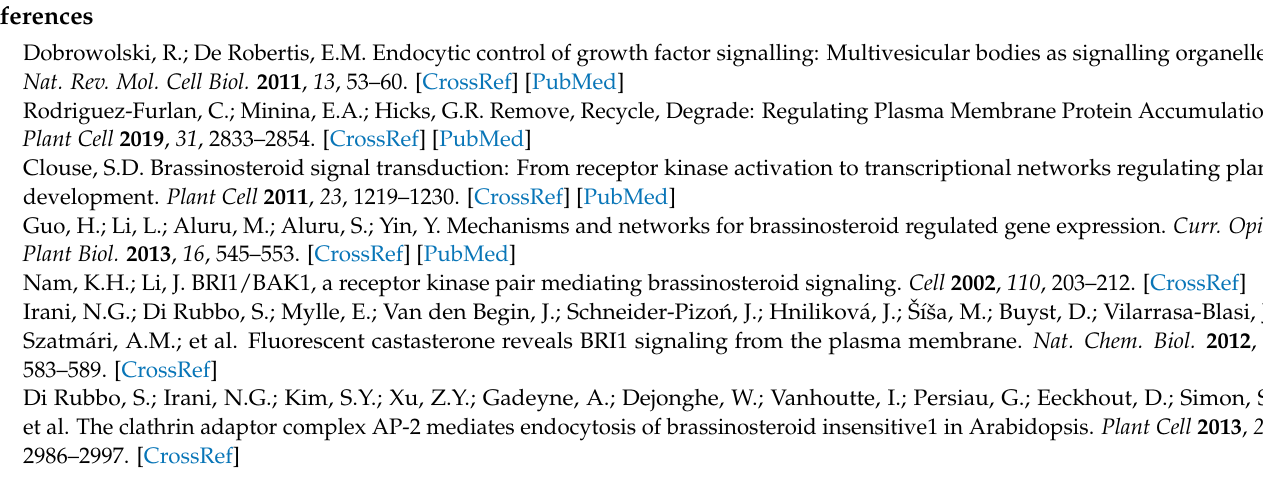
Figure S2: HSP90.1 and HSP90.2 reside at the PM; Figure S3: BRI1LRR and BRI1 KS interact differently with HSP90.1 and HSP90.2; Figure S4: BRI1 localization in hypocotyl cells of hsp90.2 ; Figure S5: HSP90 regulates the transcriptional activation of BES1; Figure S6: Images used for the analysis of BRI1 spatial clustering index of wild-type and hsp90 mutants after treatment with BL and under control conditions; Figure S7: HSP90 regulates the spatial distribution of BAK1 co-receptor at the PM; Figure S8: Images of BiFC interaction assays of HSP90.1 with full-length BRI1 protein or BRI1 with BAK1; Figure S9: HSP90.2 does not interact with BRI1 receptor in the presence of GDA; Figure S10: Unprocessed Western blot images used in this study; Table S1: Primers list; Table S2: Statistical analysis of Figure 1A; Table S3: Statistical analysis of Figure 1C (Col-0); Table S4: Statistical analysis of Figure 1C ( hsp90.1 ); Table S5: Statistical analysis of Figure 1C ( hsp90.2 ); Table S6: Statistical analysis of Figure 3B; Table S7: Statistical analysis of Figure 3C; Table S8: Statistical analysis of Figure 3E; Table S9: Statistical analysis of Figure 4E; Table S10: Statistical analysis of Figure 5E; Table S11: Statistical analysis of Figure 5F; Table S12: Statistical analysis of Figure 6E; Table S13: Statistical analysis of Figure 6F; Table S14: Statistical analysis of Figure 6G; Table S15. Statistical analysis of Figure S1C (Col-0); Table S16. Statistical analysis of Figure S1C ( hsp90.1 ); Table S17. Statistical analysis of Figure S1C ( hsp90.2 ); TableS18: Statistical analysis of Figure S5B; TableS19: Statistical analysis of Figure S5D; Table S20. Statistical analysis of Figure S5E; Table S21. Statistical analysis of Figure S5F; Table S22. Statistical analysis of Figure S5G; Table S23. Statistical analysis of Figure S6I; Table S24. Statistical analysis of Figure S6J; Table S25. Statistical analysis of Figure S7E; Table S26. Statistical analysis of Figure S7F; Table S27. Statistical analysis of Figure S8E; Table S28. Statistical analysis of Figure